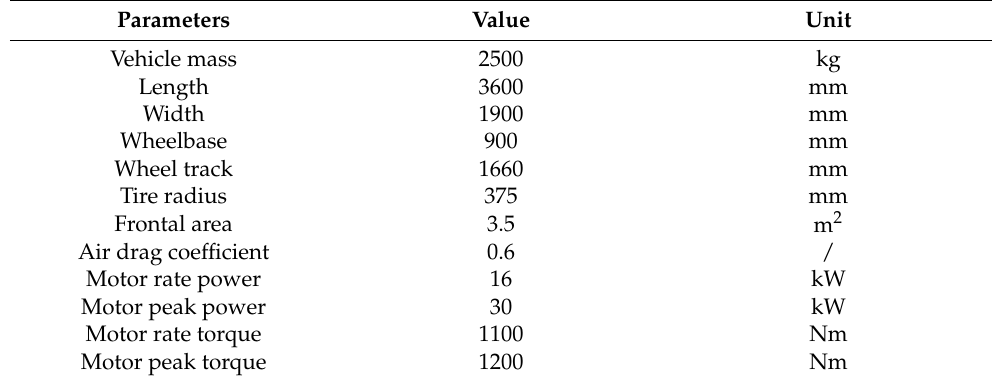
Table 1. Key parameters for